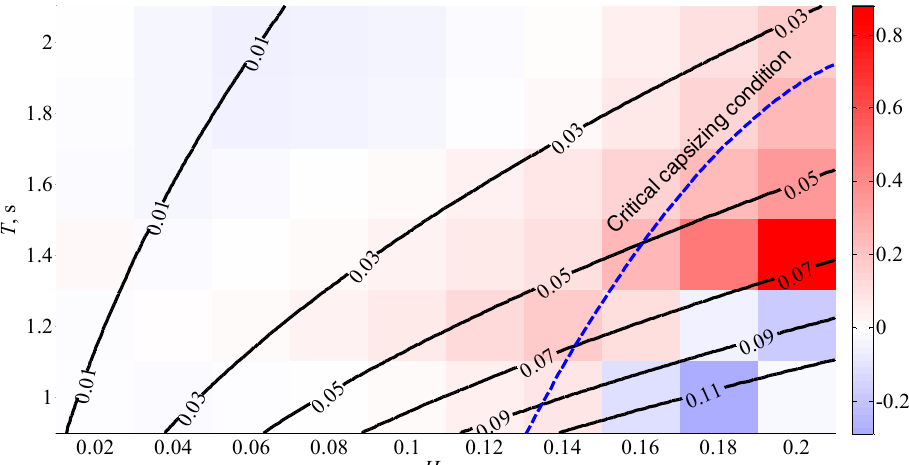
Figure 12. Relative difference of the pitch angular displacement amplitude as a function ofwave height and wave period. Contour lines of the wave steepness are shown by solid lines, while the critical capsizing condition for the Duck is shown by the dashed line.